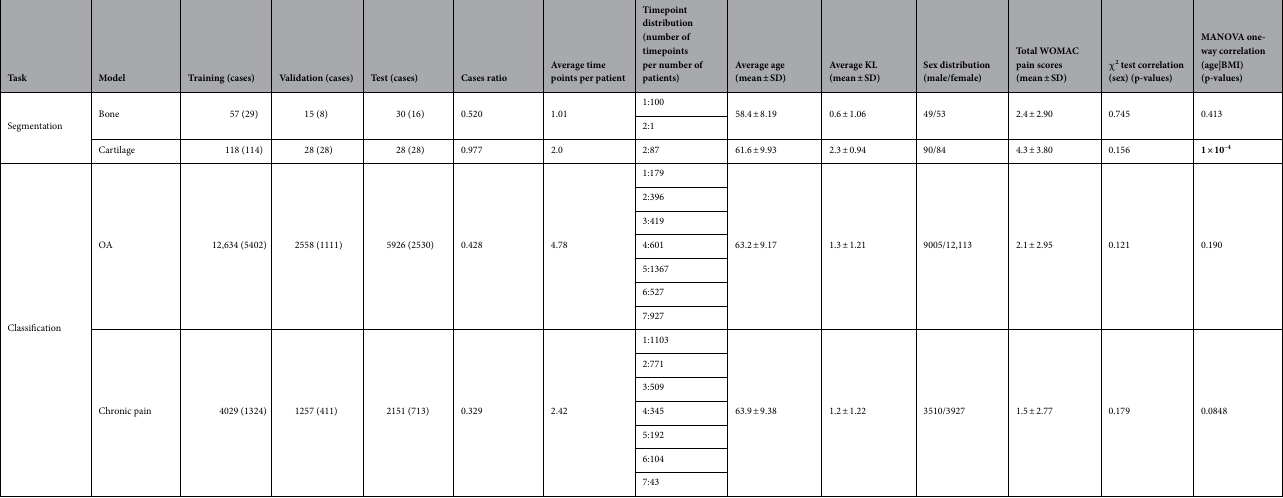
Chronic pain model training. A total of 18 binary classification models, one for each biomarker strategy per bone, were trained to extract biomarker features from the spherical biomarker representations and use them to predict chronic knee pain (Supplementary Fig. S1). Each chronic pain model was trained using 7437 spherical images divided into 4029 training images, 1257 validation images and 2151 test images, with no patient overlap across splits. To test the independence of demographic factors (sex, age, BMI) for the chronic pain cases across splits, two different statistical tests were performed. The independence of sex was tested with a Pearson’s chi- squared test while the independence of age and BMI was tested with a one-way MANOVA. Table 4 summarizes the training, validation and test set splits for the segmentation and classification models, along with the p-values of the statistical tests showing independence of demographic factors. The chronic pain prediction models were pretrained on an OA classification task. There were 21,118 cross- sectional timepoints from 4,416 unique patients. The KL grade distribution consisted of 8103 (KL = 0), 3972 (KL = 1), 5335 (KL = 2), 2897 (KL = 3) and 811 (KL = 4). The KL grades represent no OA (KL = 0), minimal/ doubtful OA (KL = 1), mild OA (KL = 2), moderate OA (KL = 3), and severe OA (KL = 4). For the purposes of this study, KL grades of 0 and 1 were determined to be healthy while KL grades of 2, 3, and 4 are considered to be OA. This study evaluated three types of Resnet 41 architectures with 18, 34, and 50 layers (Resnet18, Resnet34,